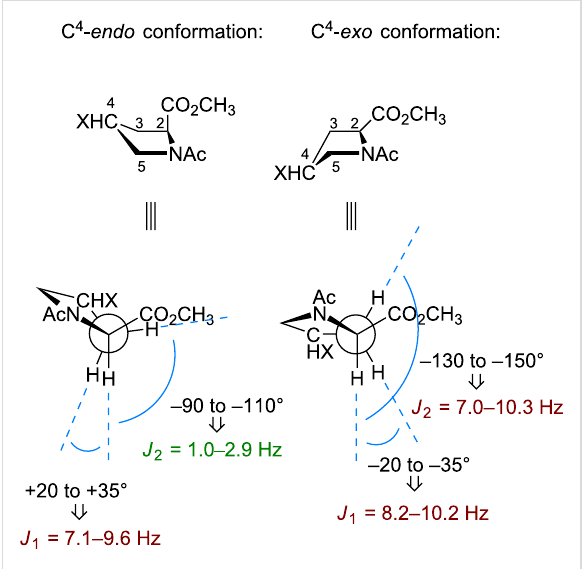
Figure 4: Propagation of the C 4 -conformation into the values of the J coupling in the C 2 H–C 3 H 2